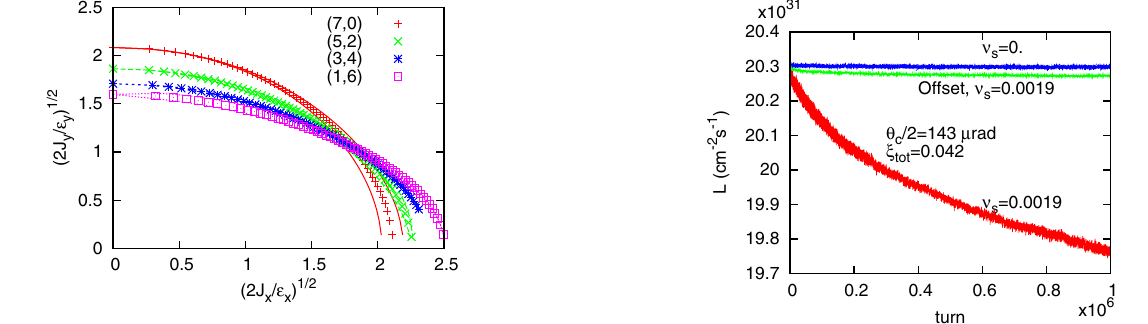
FIG. 9. Luminosity evolution for the arc transformation with or without synchrotron oscillation.